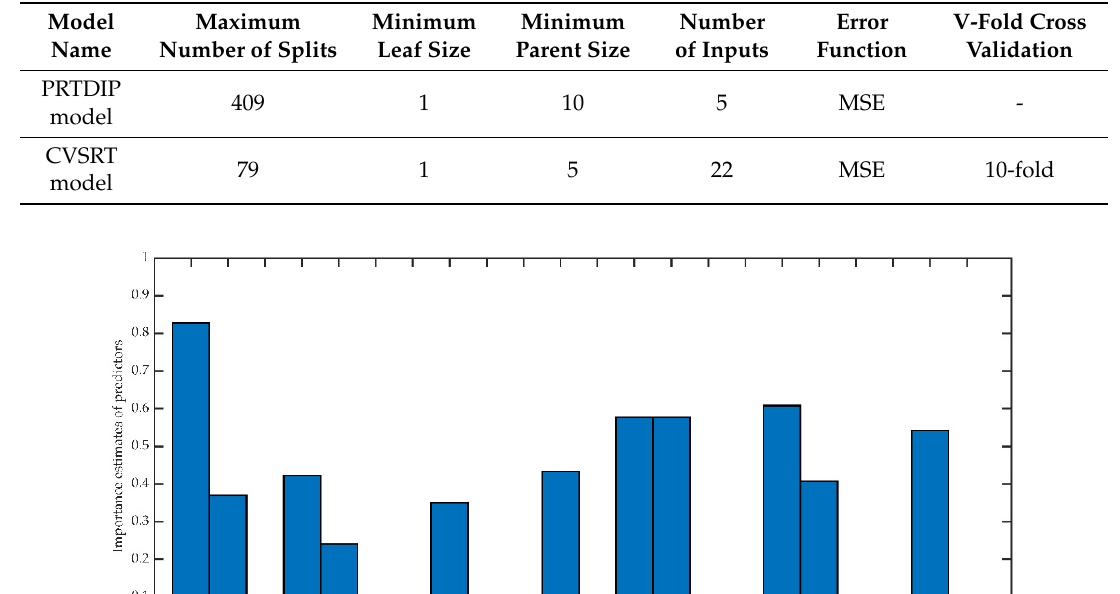
Table 3. Regression tree models to predict thermal energy production.